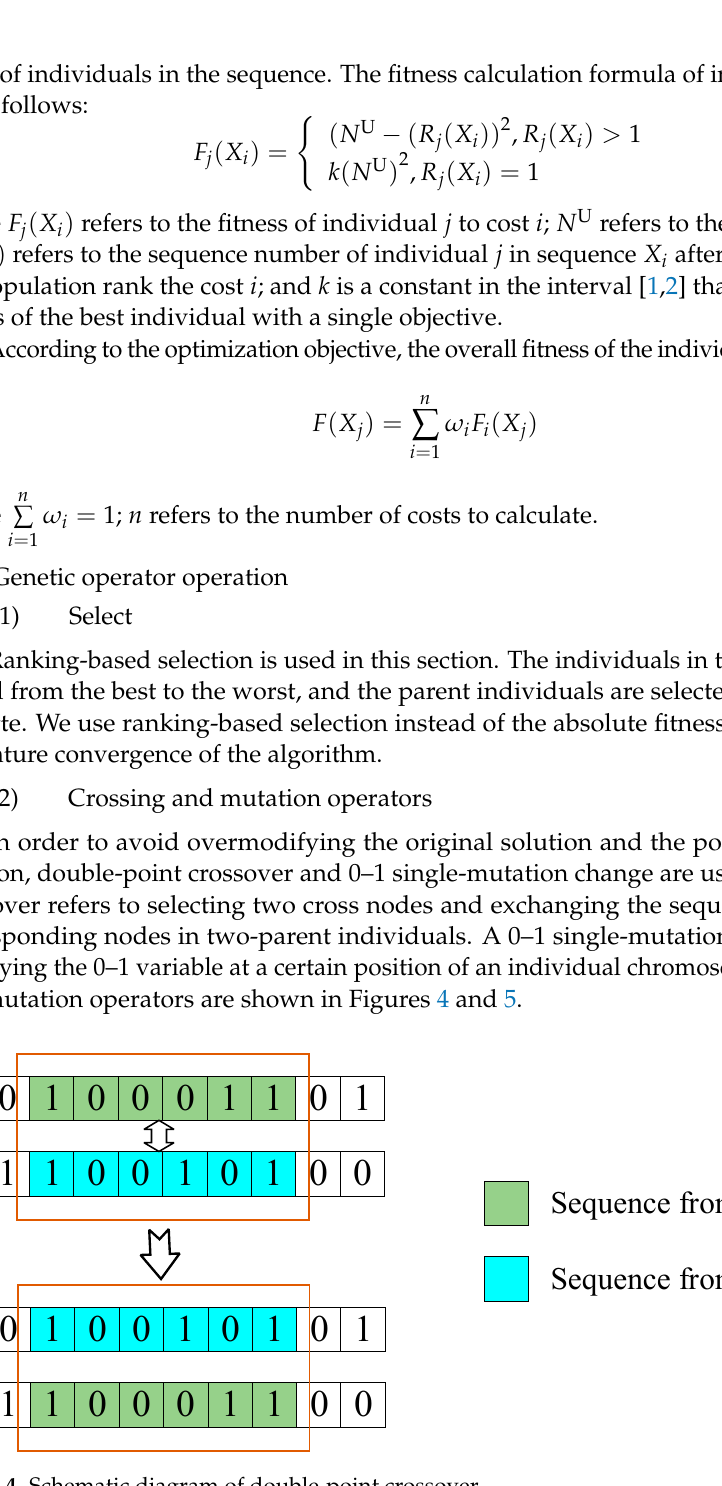
Figure 4. Schematic diagram of double-point crossover.